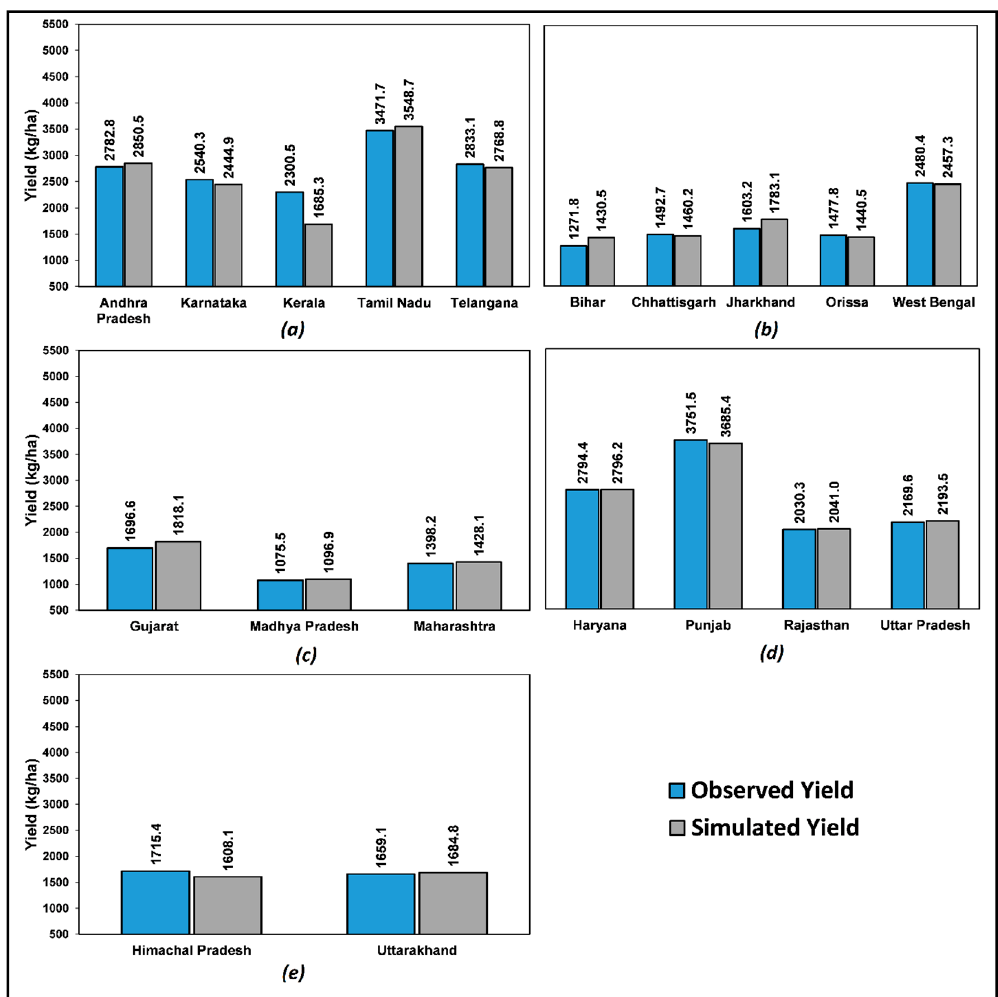
Figure 3. Comparison of state-wise average observed and simulated yields. The figure was divided into geographical zones in India, such as Southern India ( a ), Eastern India ( b ), Central India ( c ), Indo Gangetic Plains and Western India ( d ), and Western Himalayan Region ( e ). Blue bars show observed yields, while grey bars show the simulated yields.